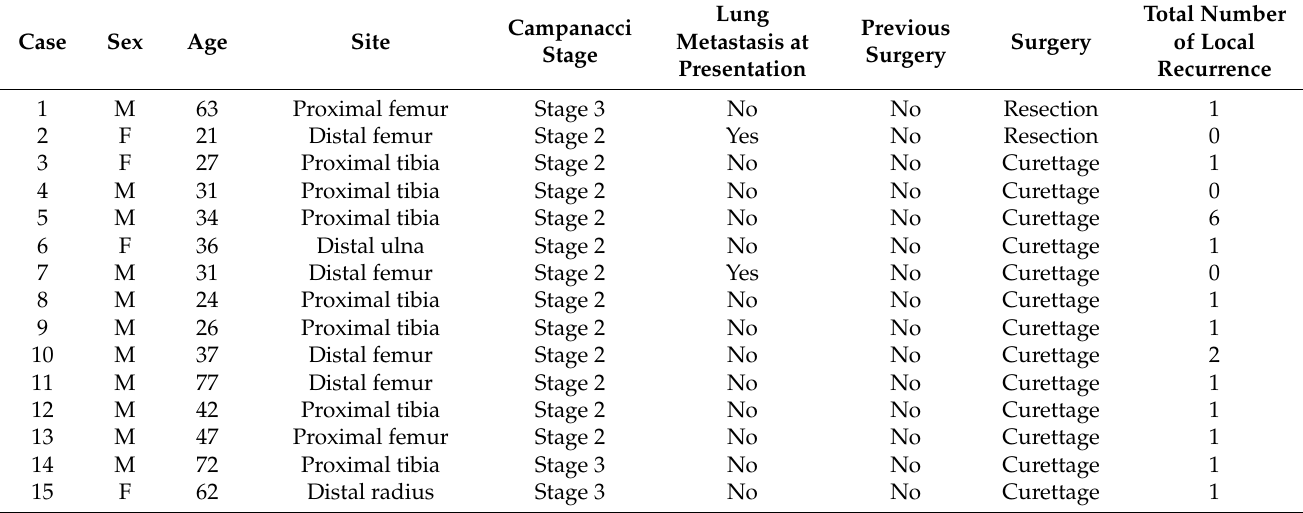
Table 2. Details of 15 patients who experienced malignant transformation from benign GCTB.